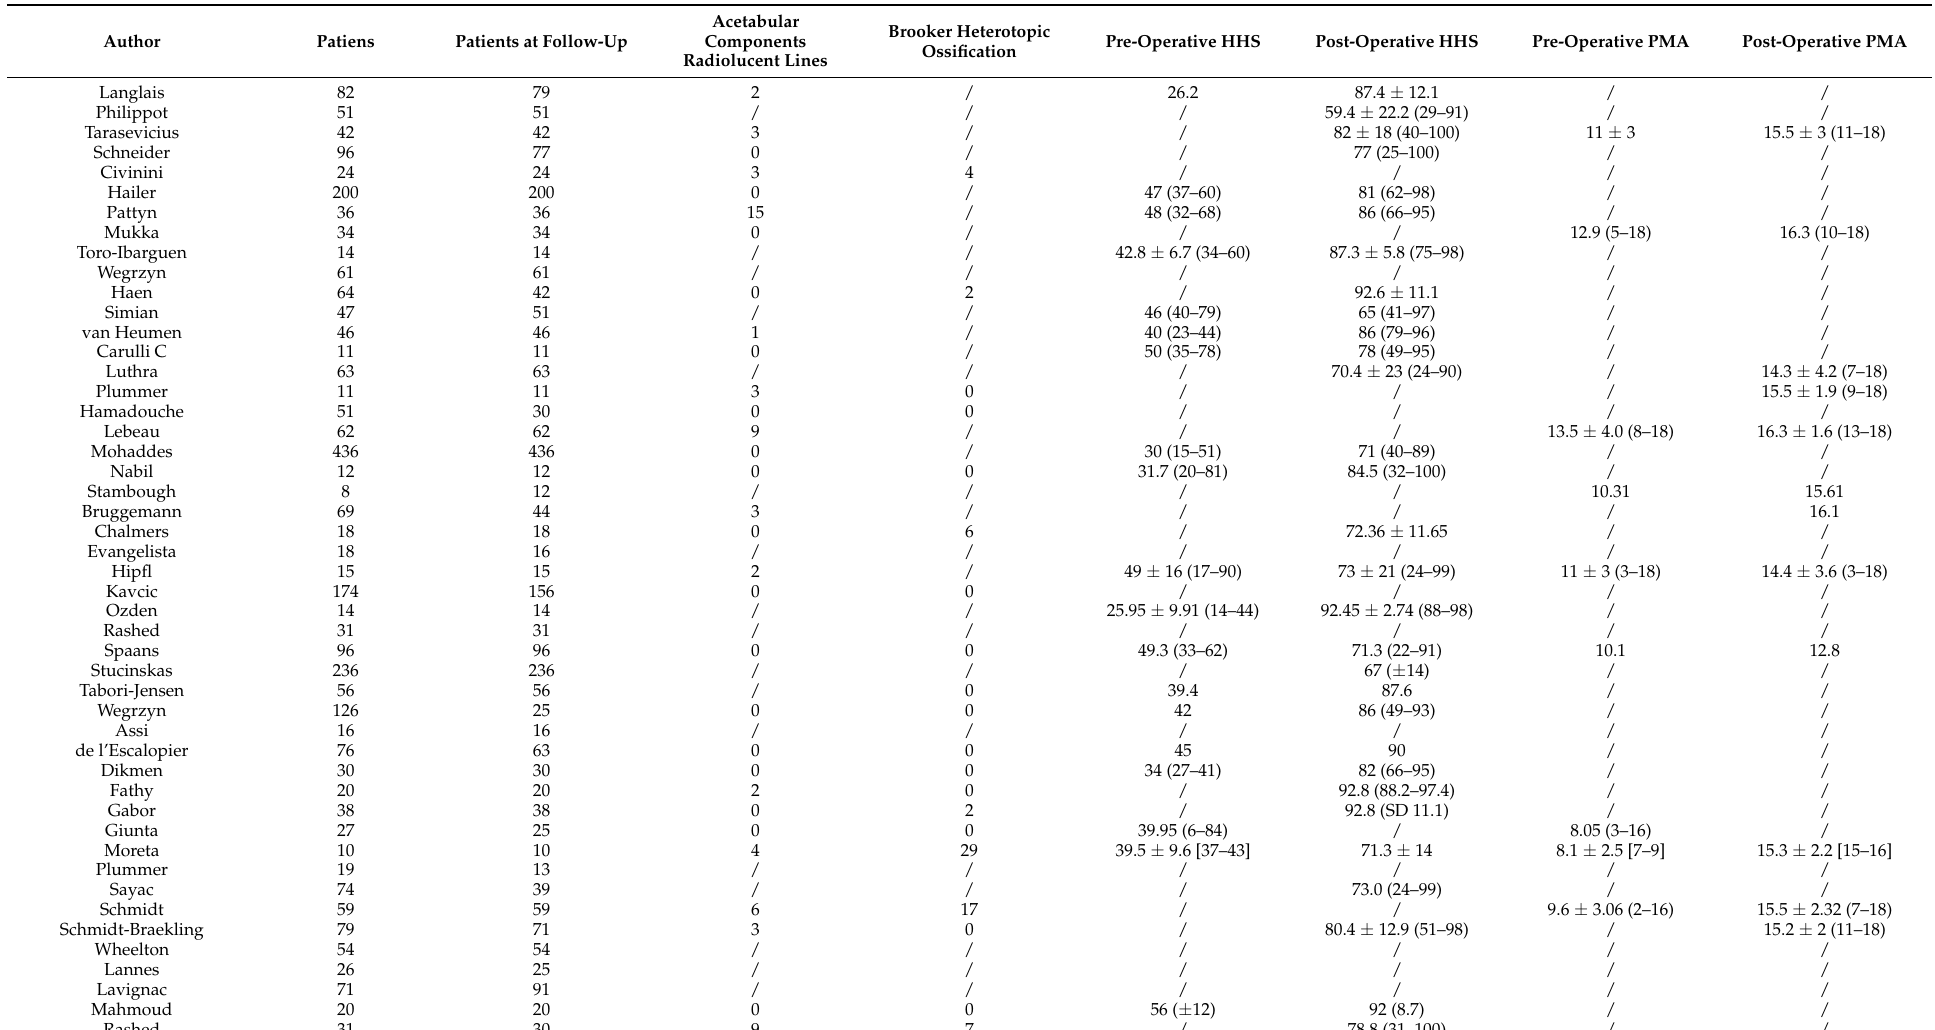
Table 5. Cemented dual mobility cup: radiographic and functional